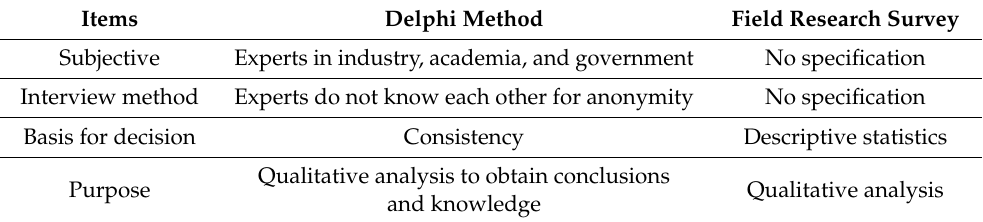
Table 1. Comparison of Delphi method and Field research survey.